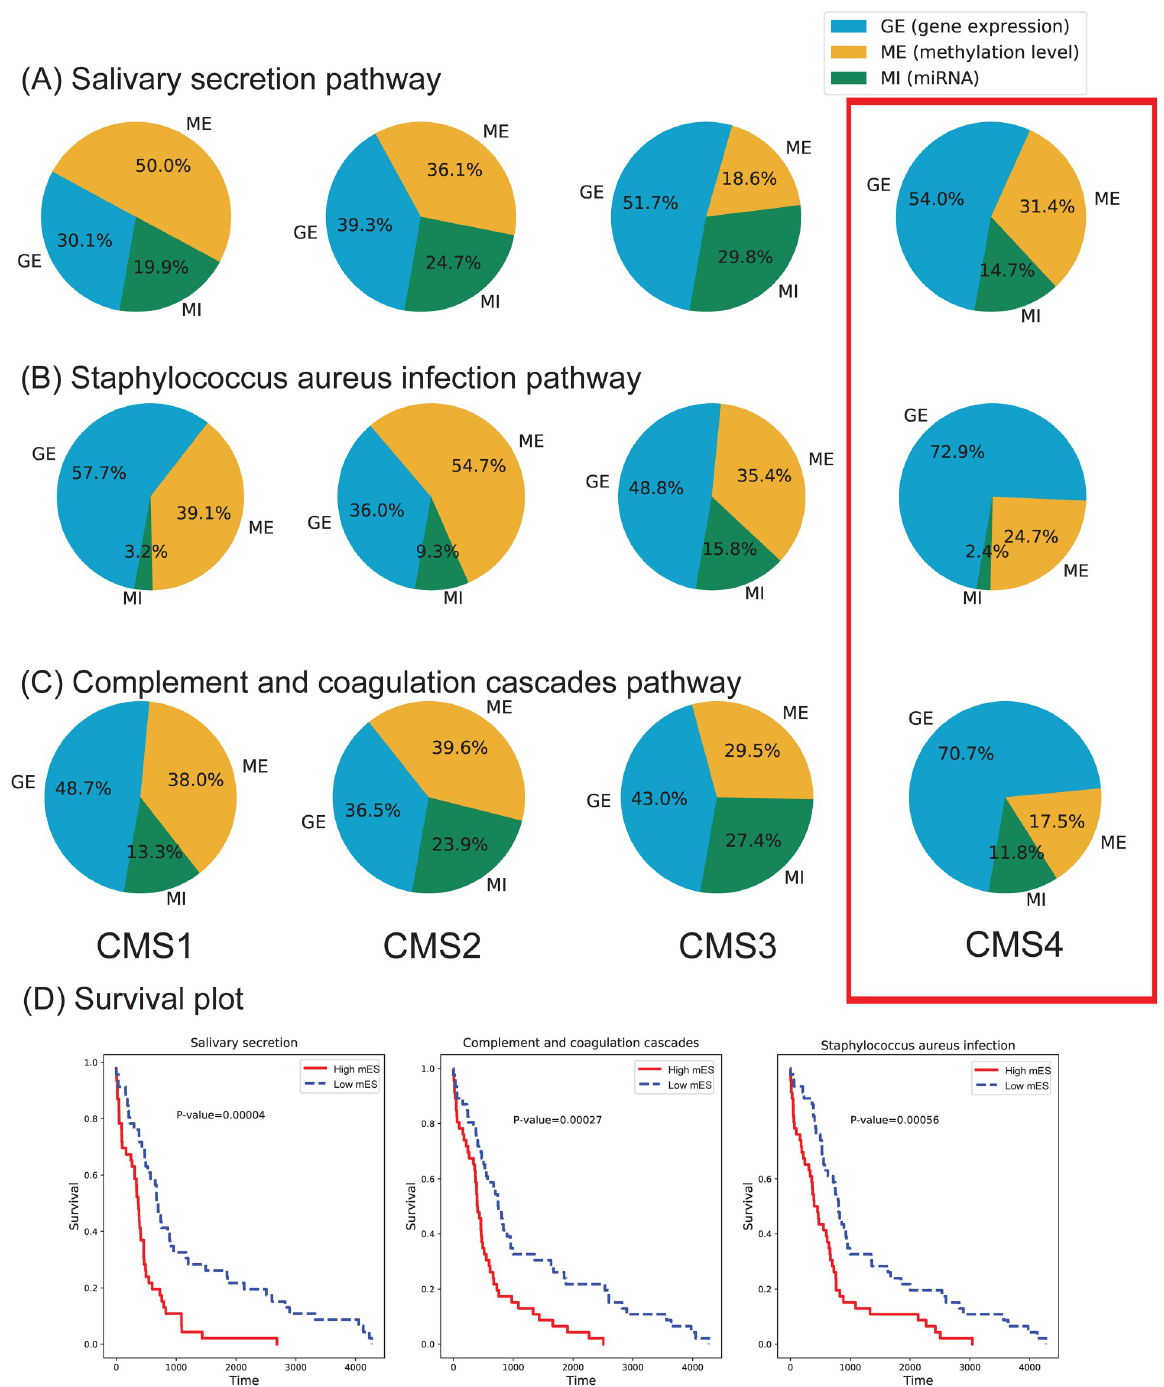
Fig 11. The OCR and survival plots of three pathways are shown for each COAD subtype. (A), (B) and (C) represent the OCR of the pathways, respectively. (D) The survival plots of the three pathways.